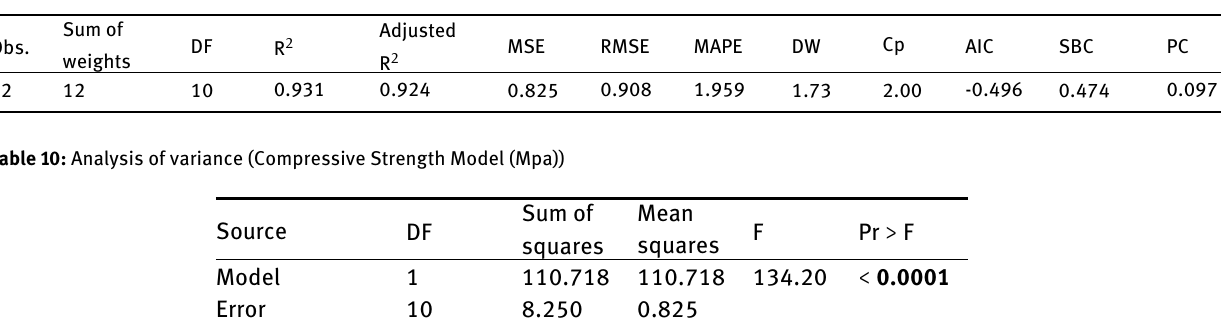
Table 9: Goodness of fit statistics (Compressive Strength Model (MPa)